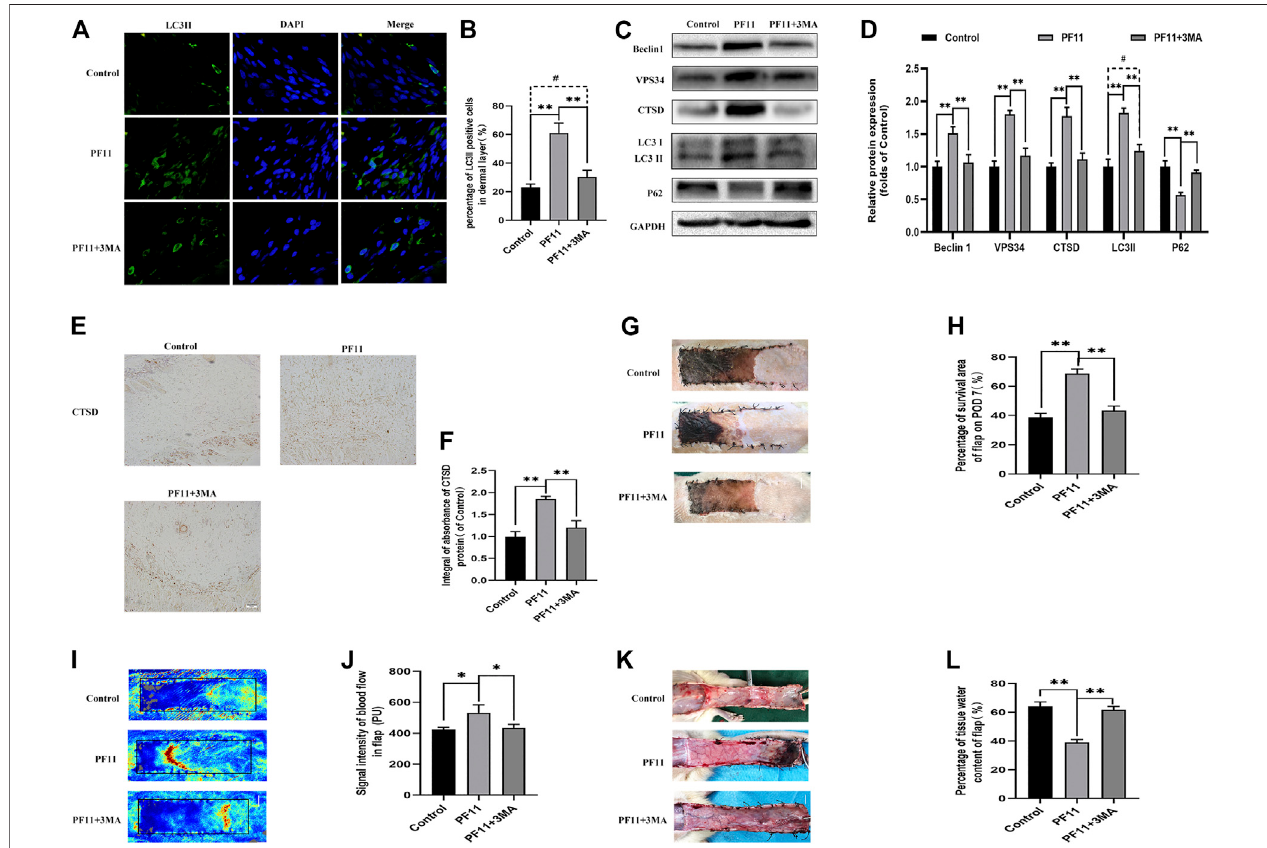
FIGURE 5 | Inhibition of autophagy reverses the positive effects of PF11 on random-pattern skin fl ap. (A,B) Immuno fl uorescence staining for LC3II positive cells in Area II of fl aps (scale bar: 20 μ m). (B) A histogram showing the percentage of LC3II positive cells. (C,D) Western blotting was performed to assess the expression of autophagy-relatedproteinBeclin1,VPS34,CTSD,p62,andLC3II. (E,F) IHCresultsshowingtheexpressionofCTSDinthecontrol,PF11,andPF11+3MAgroups(scan bar,50 μ m). (G,H) Digitalphotographsshowingthepercentageofsurvivalareaofthe fl aponthe7thPOD(scalebar,1 cm). (I,J) Thesignalintensityofblood fl owas detectedbyLaserDoppleronthe7thPOD(scalebar,1 cm). (K,L) Photographexhibitingedemaandvascularnetworkontheinnersideoftheskin fl ap(scalebar,1 cm). Values are expressed as means ± SD, n (cid:2) 6 per group. * p < 0.05 and ** p < 0.01, vs. PF11 group. # p < 0.05 and ## p < 0.01, vs. control